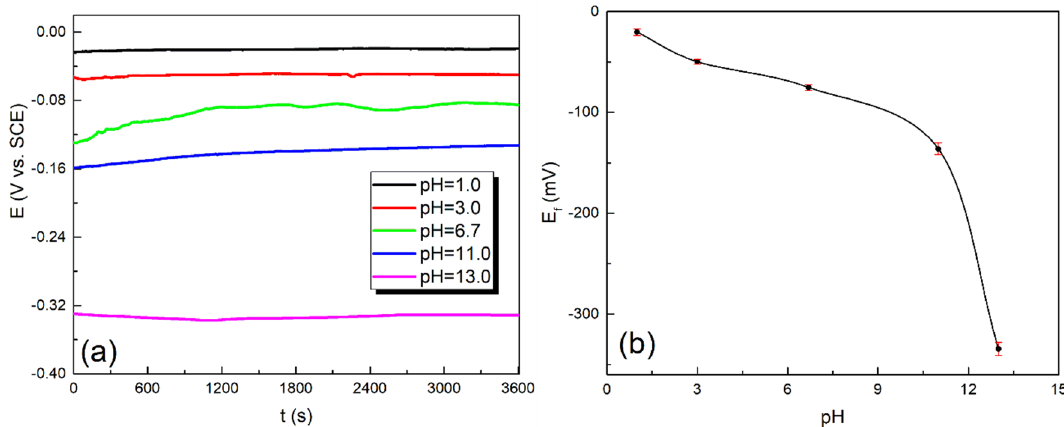
Figure 2. The variation of OCP for galena with time in NaCl solutions with different pH ( a ), and ( b ) the relationship between E f and pH.